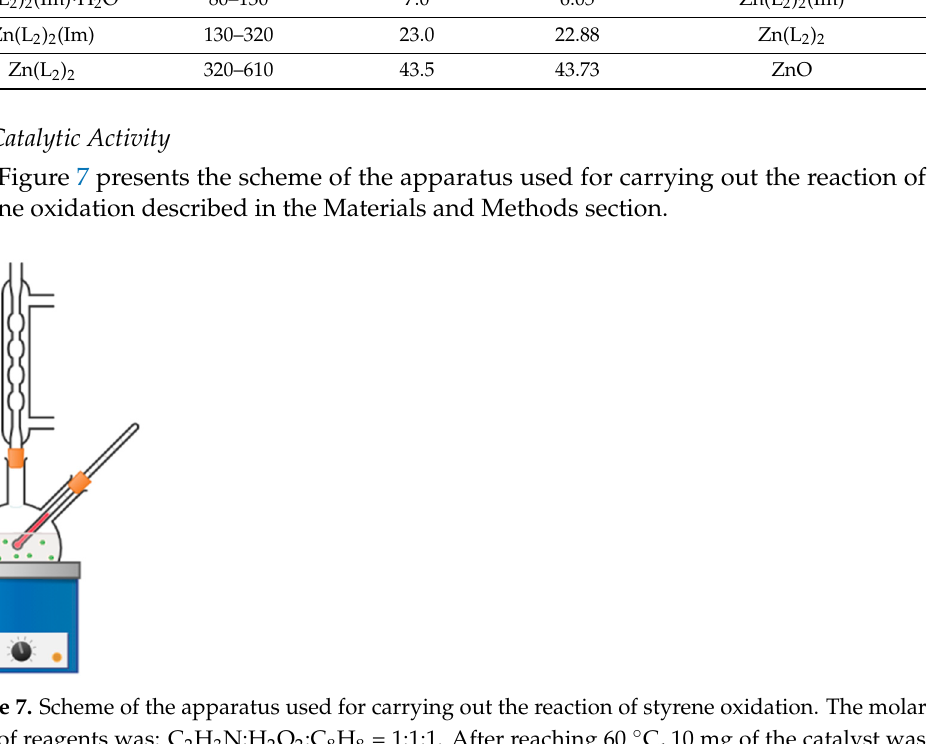
Table 12. Conversion degrees for eight described compounds (M(II) formate or propionate com- plexes with imidazole) and for four previously studied compounds [25] (M(II) acetate complexes with imidazole).